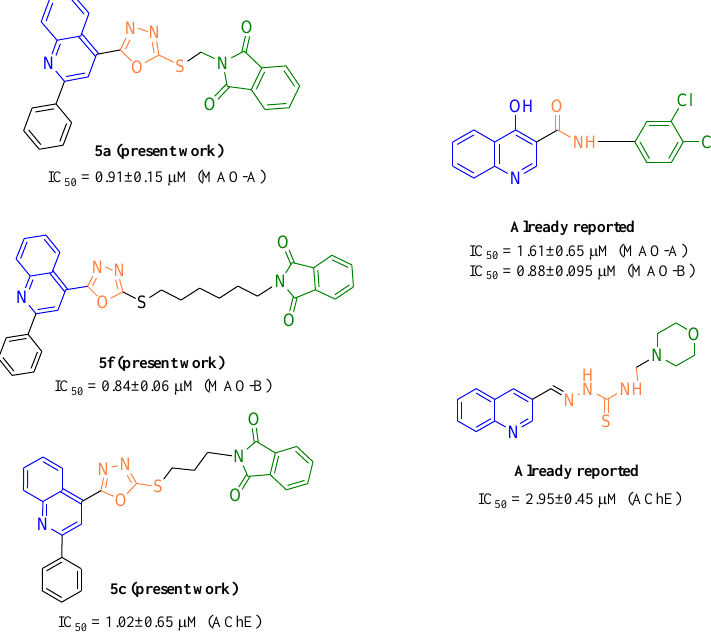
Figure 2. Potent compounds on MAO-A, MAO-B, and AChE enzymes.